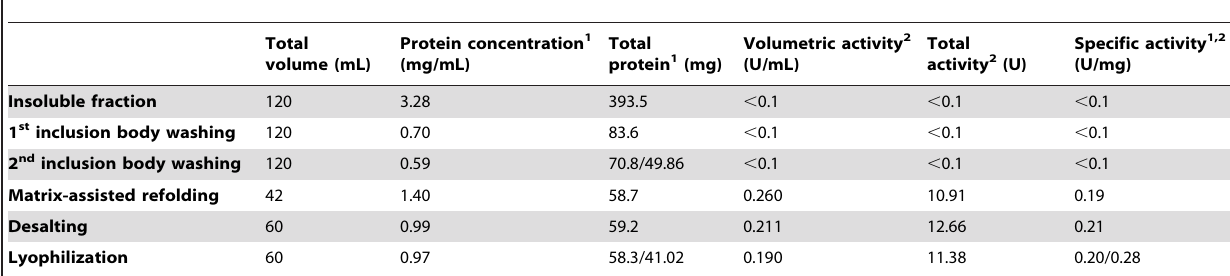
Table 4. Refolding of Ta AlDH from 10 g of E. coli cells produced in 1 L of fed-batch